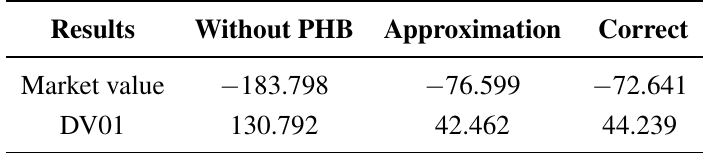
Table 1. Market value of the cash flow and dollar durations (DV01), without policyholder behavior (PHB), with the approximative method and the correct method. The duration is greatly reduced when policyholder behavior is included, and the approximation is close to the result from the correct